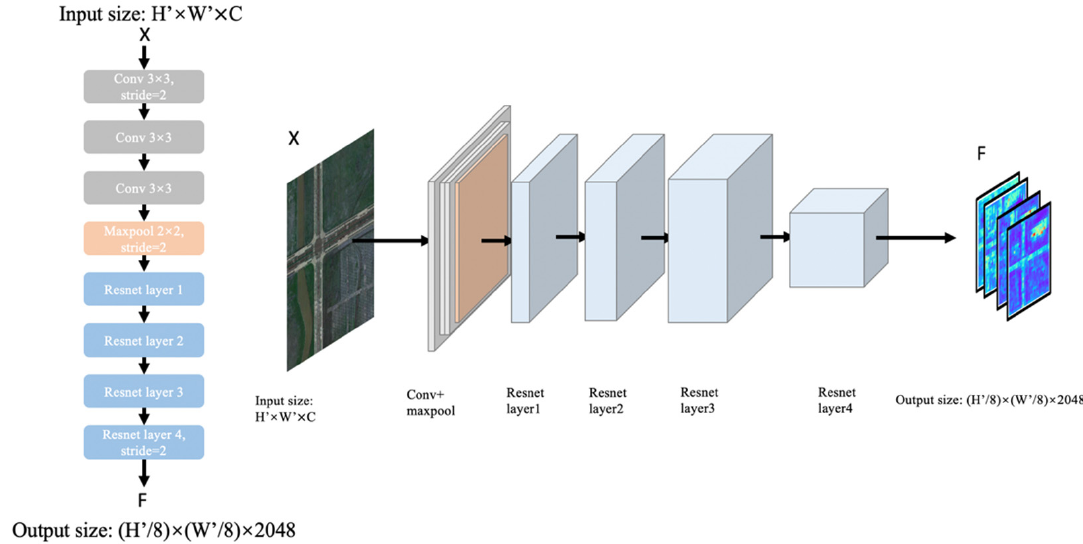
Figure 3. The backbone part.